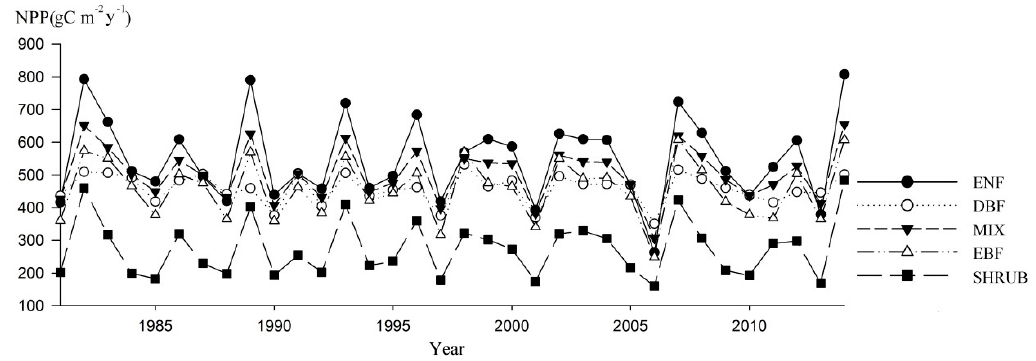
Figure 3. Time series of NPP for various forests in TGRA from 1981 to 2014.